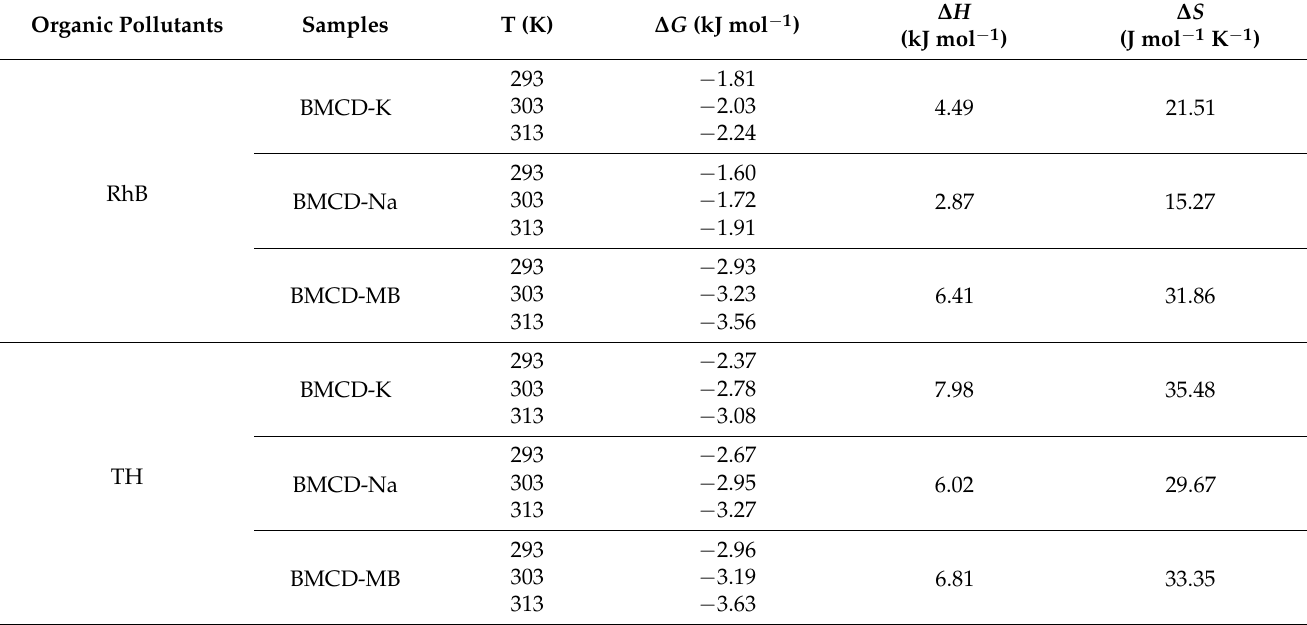
Table 4. Fitting adsorption thermodynamic parameters for RhB and